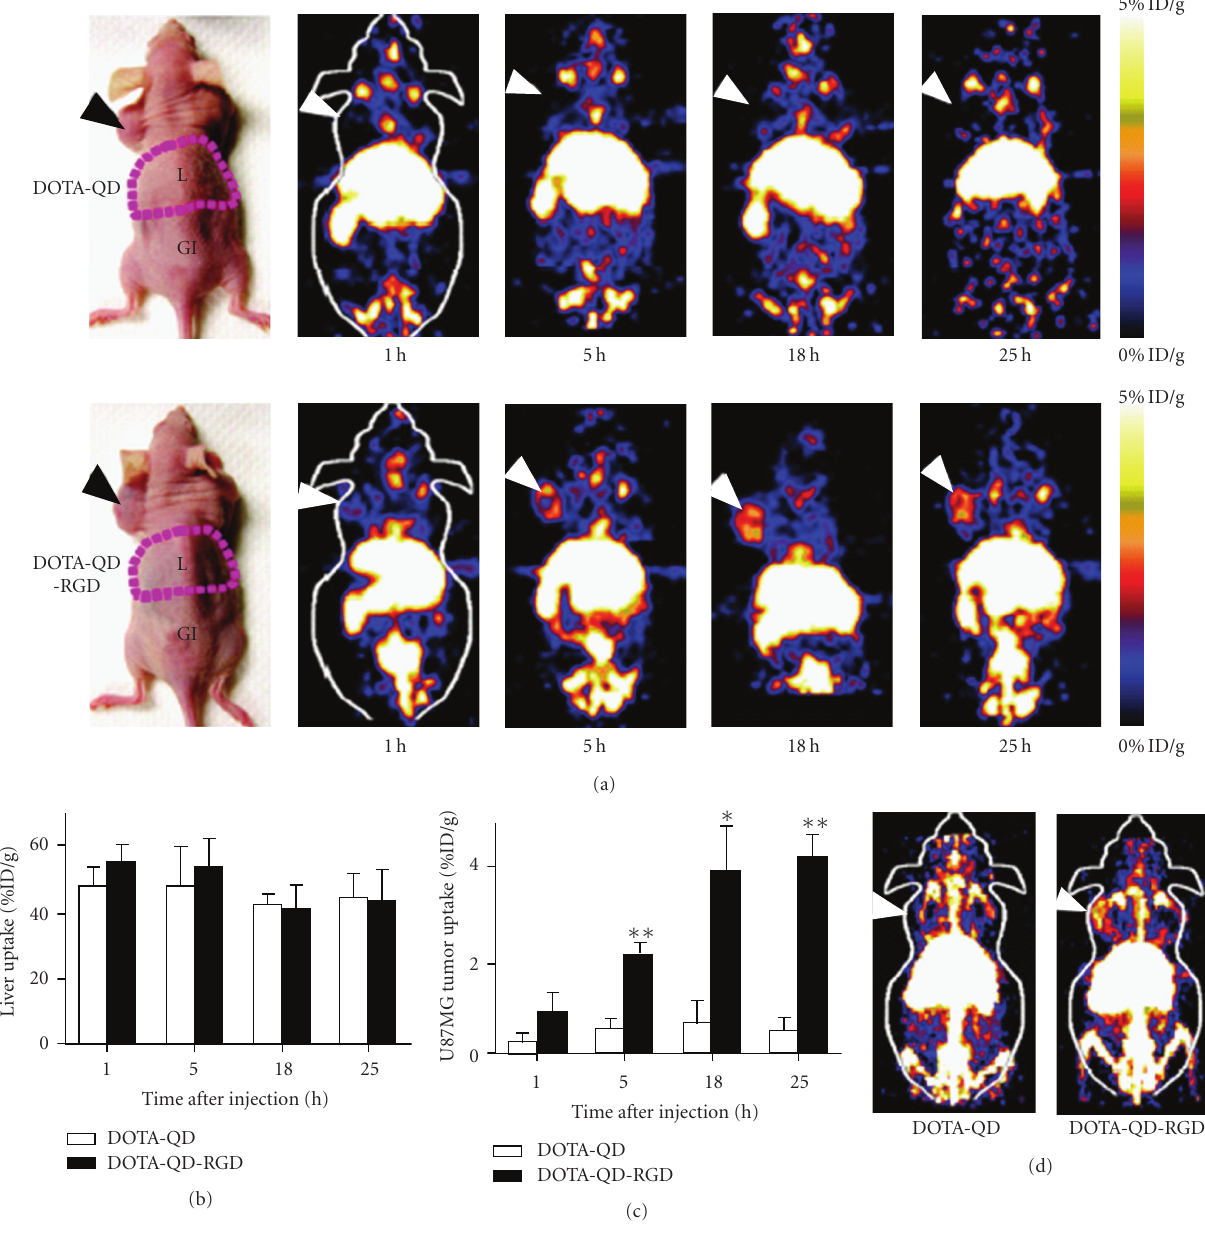
Figure 3: In vivo actively nanotargeted radionuclides of 64 Cu-DOTA-QD-RGD for dual-function PET and near-infrared fluorescence (NIR) imaging of U87MG tumor vasculature mice animal model. (a) PET images of 64 Cu-labeled nanoparticles of DOTA-QD or DOTA-QD- RGD. Arrow heads indicate tumors. (b) Liver uptake of 64 Cu-labeled nanoparticles of DOTA-QD or DOTA-QD-RGD. (c) U87MG tumor uptake of 64 Cu-labeled nanoparticles of DOTA-QD or DOTA-QD-RGD. (d) Two-dimensional image of the 2 mice shown in (a) at 5hr after injection (reprinted with permission from reference [37]). DOTA: 1,4,7,10-tetraazacyclodocecane- N, N (cid:2) ,N (cid:2)(cid:2) ,N (cid:2)(cid:2)(cid:2) - tetraacetic acid chelators for radionuclides labeling. QD: Quantum dots conjugated with NIR probe. RGD: Arginine-glycine-aspartic acid peptide for targeting tumor angiogenesis integrin α v β 3